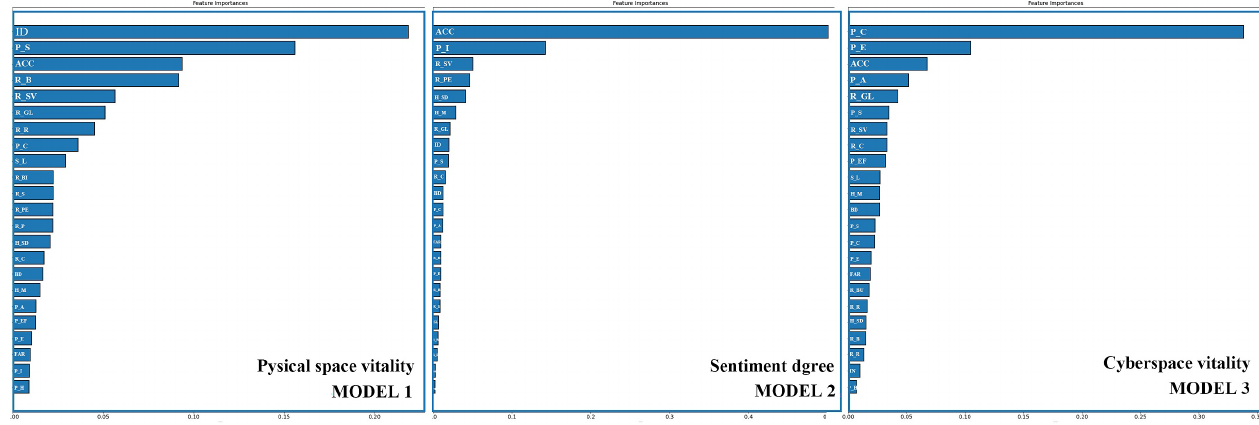
Figure 6. Feature importance for three models.